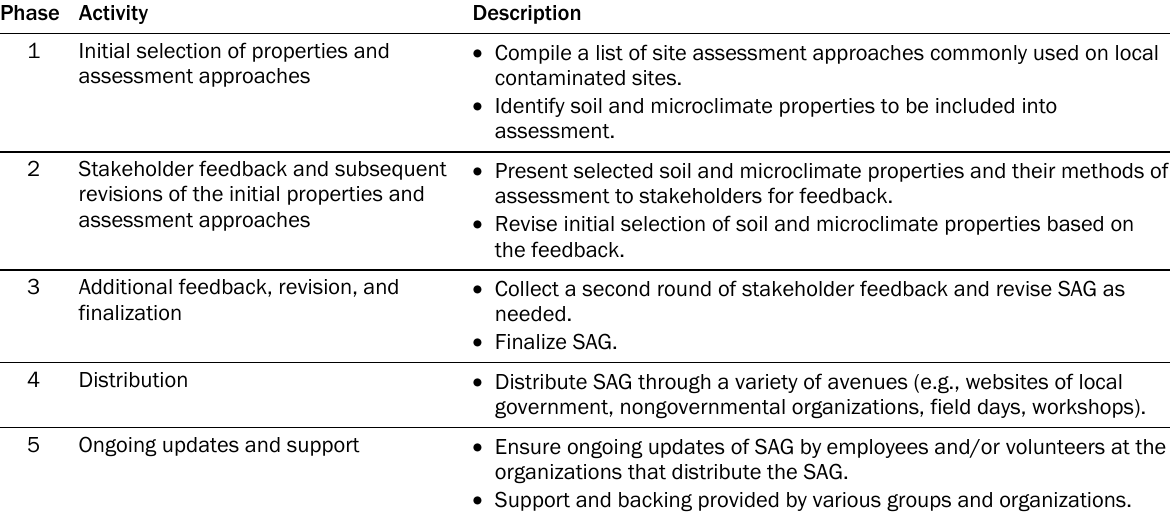
Table 1. The Five Phases of the Framework for the Urban Site Assessment Guide